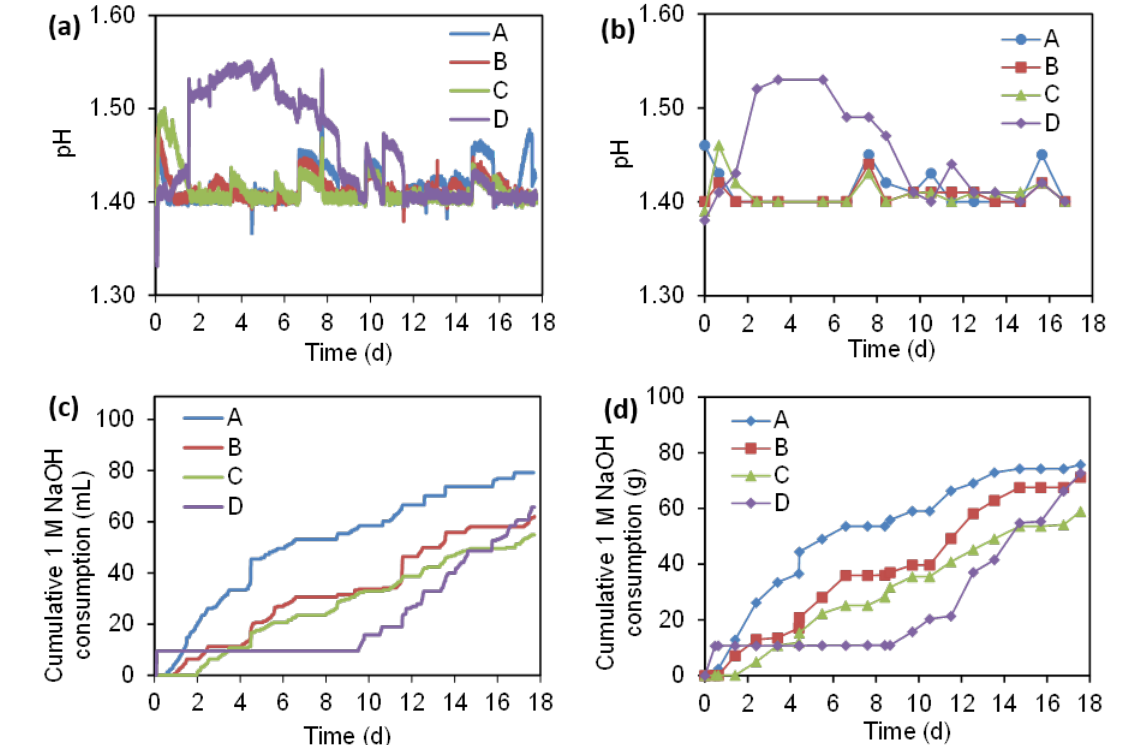
Figure 5. ( a ) Solution pH recorded via Labview program and ( b ) read manually from pH monitors, ( c ) volumetric base consumption recoded via Labview program and ( d ) base consumption determined by weight change of the NaOH bottles during the pyrite oxidation experiments with reactors A – D.